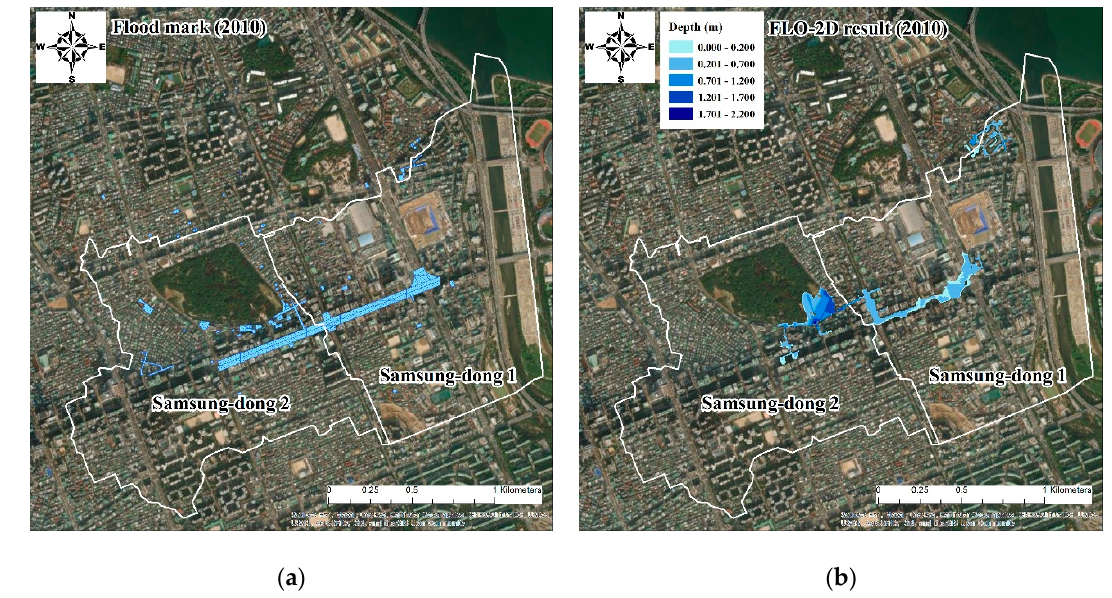
Figure 3. Verification of two-dimensional flood analysis results. Figure 2. ( a ) Actual rainfall sample on 21 September 2010 and ( b ) 6-h extreme Huff rainfall sam- ple.